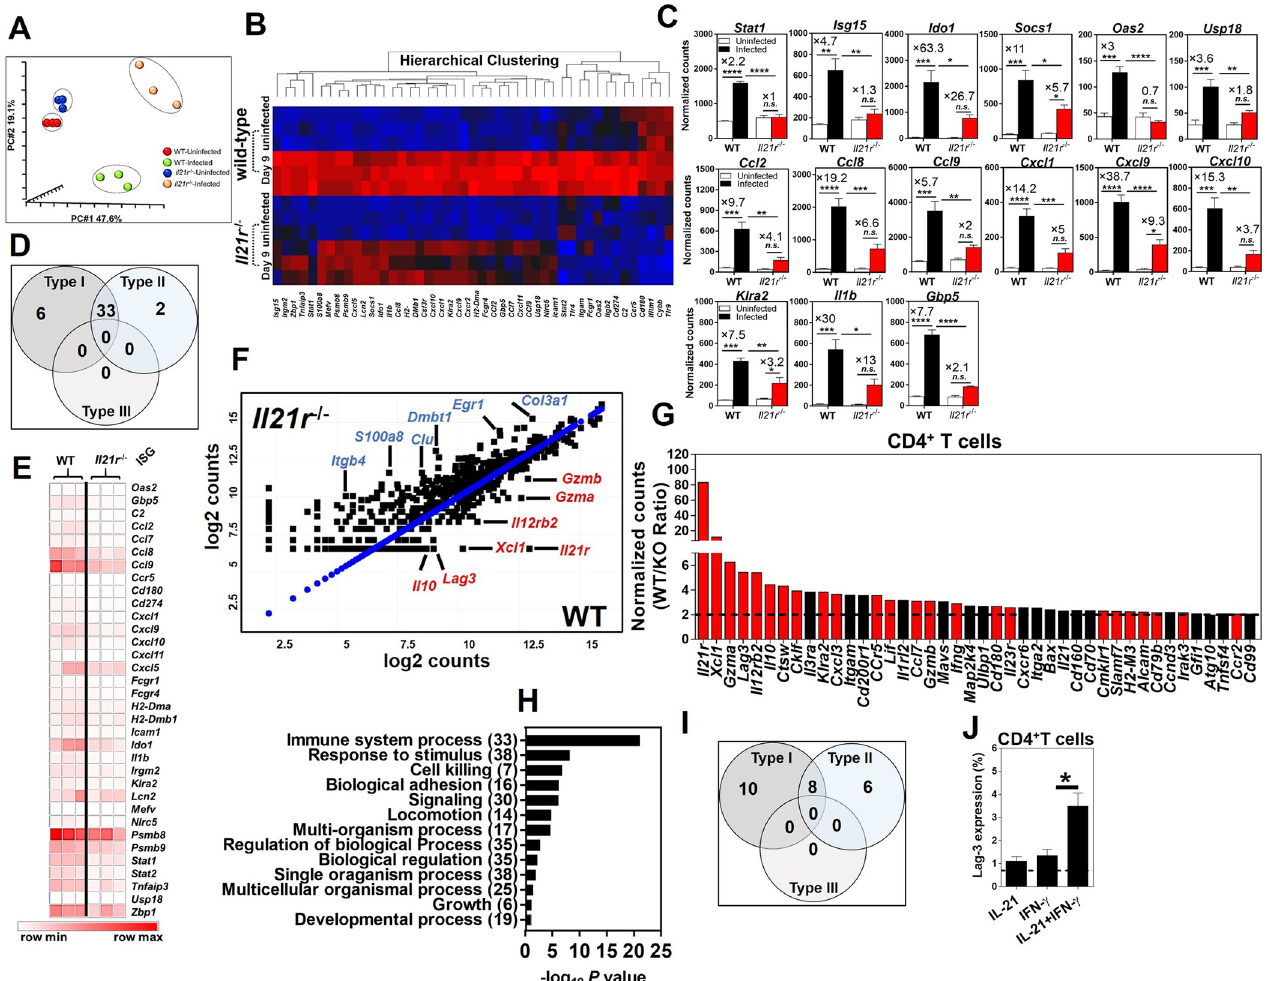
Fig 3. IL-21/IL-21R signaling axis is critical for the optimal expression of ISGs following colon infection. A . Principal component analysis (PCA) of Nanostring gene expression datasets from whole distal colons of uninfected and infected WT and Il21r -/- mice at 9 days p.i. ( n = 3/genotype/time-point). B . Heatmap of differential gene expression profiles in the whole distal colon of uninfected and infected WT and Il21r -/- mice at 9 days p.i. (red, upregulated; blue, downregulated). C . Normalized expression levels of ISGs in the whole distal colon of uninfected versus infected WT and Il21r -/- mice at 9 days p.i. ( n = 3/ genotype/time-point). The gene expression of each gene was normalized to the geometric mean of the expression of internal reference genes and presented as normalized counts/gene/biological sample (see Nanostring Methods). Genes with fold difference � 2 between WT/ Il21r -/- mice were considered. Data represent the mean ± SEM of normalized counts. � p < 0.05; �� p < 0.01; ��� p < 0.001; ���� p < 0.0001; One-way ANOVA followed by Bonferroni post-hoc adjustment test for multiple comparison. D . Venn diagram representing the number of type I-, type II- and type I/II-specific ISGs, as analyzed using the Interferome Database with impaired upregulation during infection in the whole distal colon of Il21r -/- mice 9 days p.i. versus WT controls. E . Heatmap of differential expression of ISGs in the whole distal colon of Il21r -/- mice as compared with WT controls at 9 days p.i. F . Scatter plot representation (log 2 values) of gene expression levels in FACS-sorted mucosal CD4 + T cells isolated from the distal colon of WT and Il21r -/- mice at 9 days p.i. G . Histogram shows fold impairment of genes in rank order in Il21r -/- mice versus WT controls (Bars in red represent known ISGs, and appear to be the dominant class of gene impaired). Black bars represent impaired genes in CD4 + T cells from Il21r -/- mice that are not known ISGs. Genes with fold difference � 2 between WT/ Il21r -/- mice were considered. H . Gene ontology analysis of processes enriched in mucosal CD4 + T cells from the distal colons of WT controls versus Il21r -/- mice (WT/ Il21r -/- ratio) 9 days p.i. Genes with fold difference � 2 were considered. I . Venn diagram representing the number of type I-, type II-, type III- and type I/ II-specific ISGs impaired in FACS-sorted CD4 + T cells isolated from the distal colon of Il21r -/- mice 9 days p.i., as analyzed using the Interferome Database. J . The induction of a representative ISG, LAG-3, in CD4 + T cells isolated from na ï ve Il21r -/- mice and WT controls. Cells were cultured in the presence of mIFN- γ (20 ng/ml) or mIL-21 (20 ng/ml) alone or in combination for 24 hr and the surface expression of LAG-3 was determined by flow cytometry. Data are the Mean ± SEM from two pooled independent experiments with a total of 6 ( Il21r -/- ) or 6 (WT) mice/group. � p < 0.05 determined by Mann-Whitney U